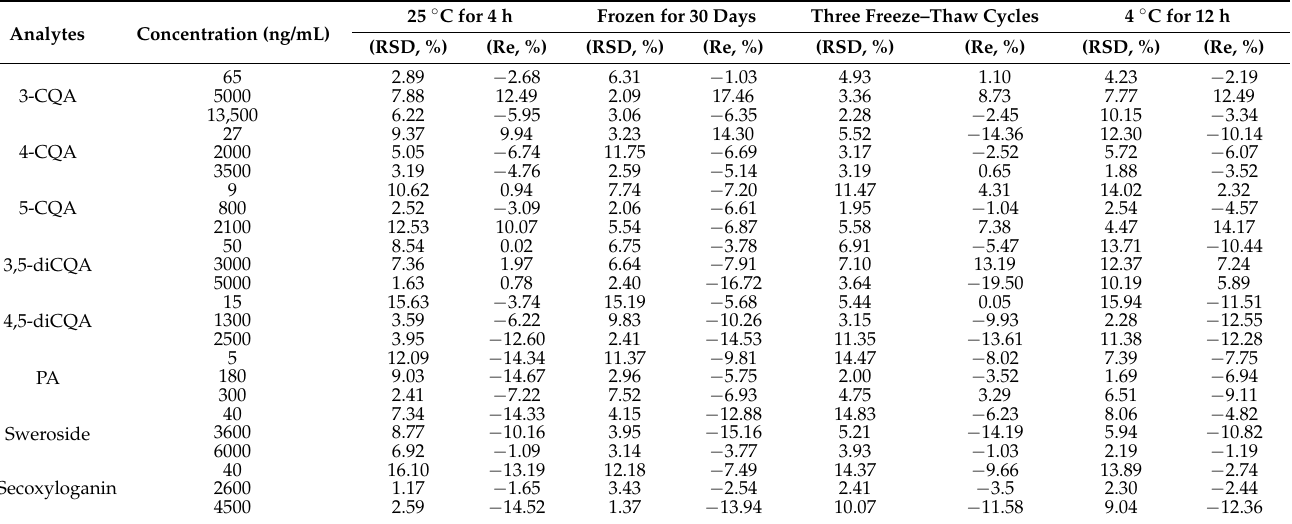
Table 5. The stability of the eight compounds in rat plasma under different storage